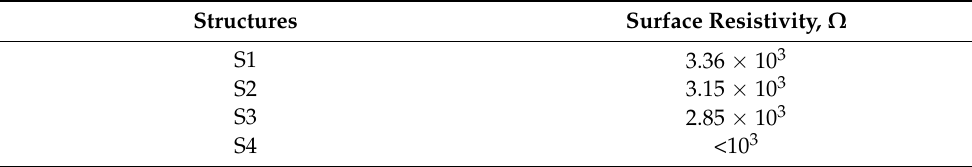
Table 3. Surface resistivity for different composite structures. Structures